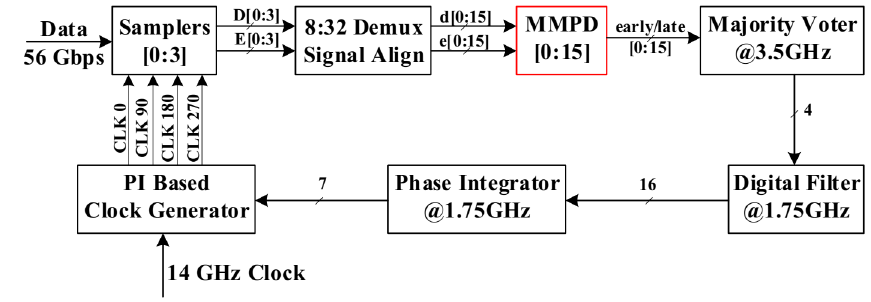
Figure 6. The architecture of 56 Gb/s quarter-rate MMPD-based digital